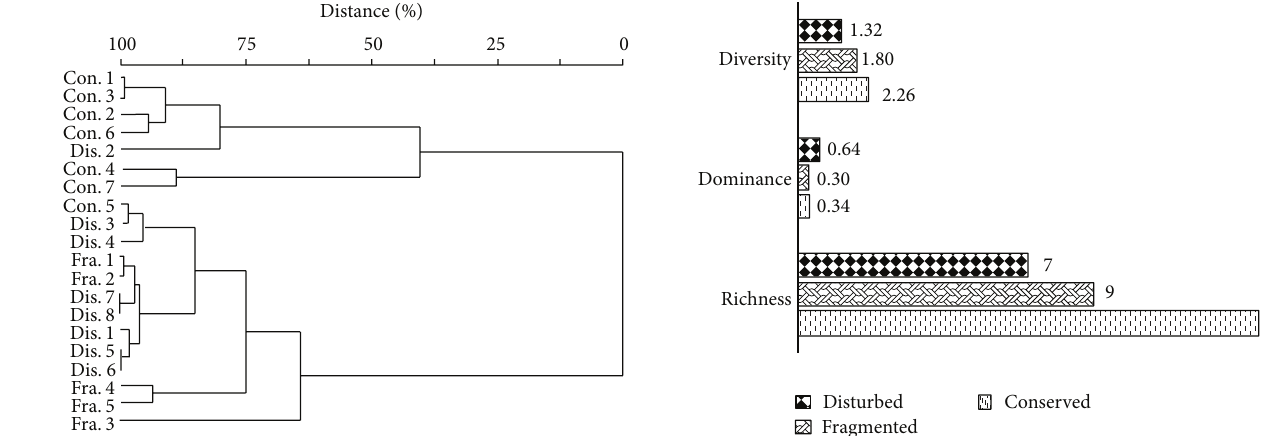
Figure 3: Dominance, diversity, and species richness in the three agroecosystems.